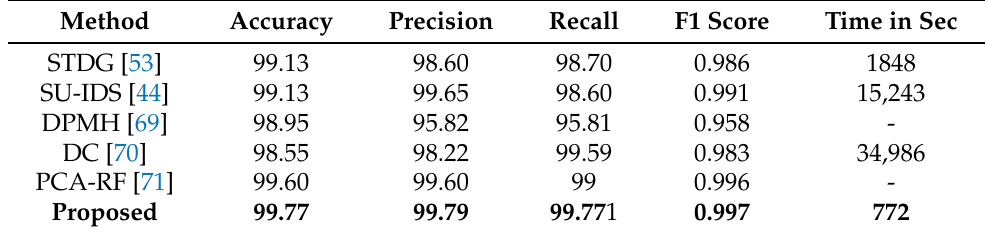
Table 2. Comparison with other models.